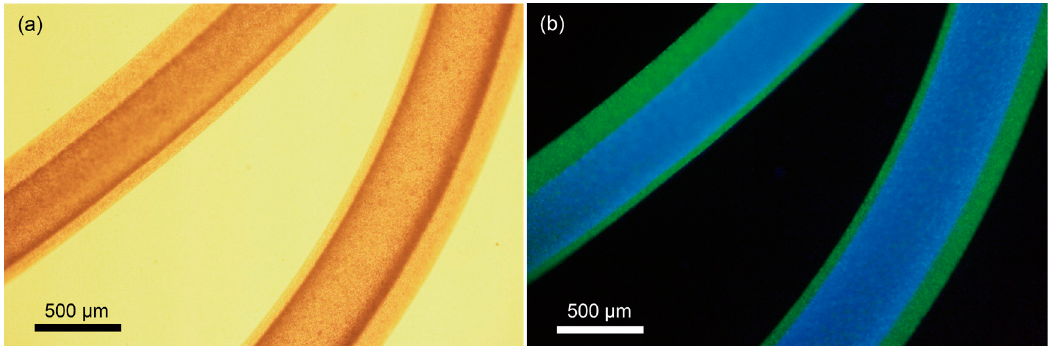
Figure 3. Micrographs of the hollow hydrogel microfiber. ( a ) Optical micrograph. ( b ) Fluorescent micrograph corresponding to (a). The fiber is colored with blue and green fluorescent particles for the core and the shell region, respectively.